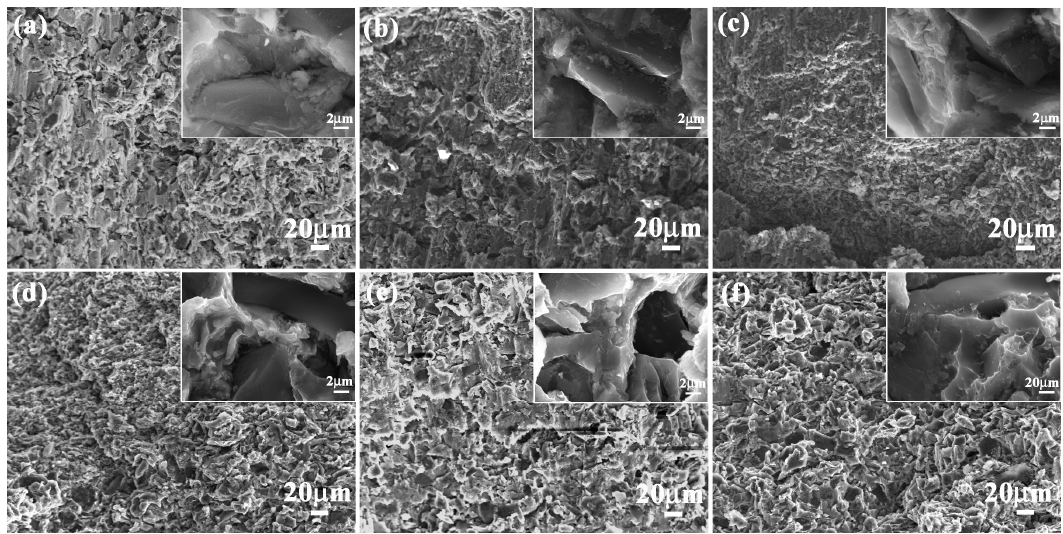
Figure 9. Compression appearance of ( a ) Outer layer; ( b ) Middle layer and ( c ) Inner layer of bionic Meretrix lusoria shell composite material and ( d ) Outer layer; ( e ) Middle layer and ( f ) Inner layer of bionic Rapana venosa shell composite material.